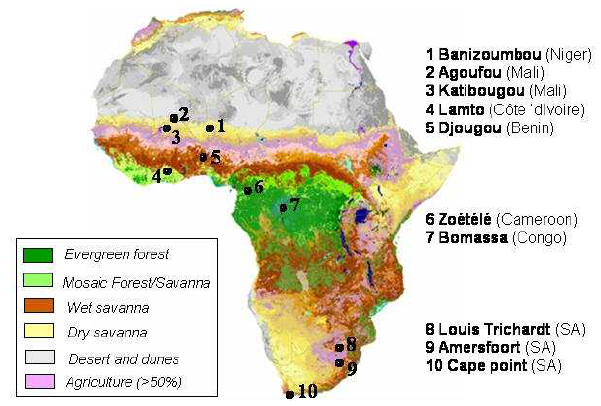
Fig. 1. Vegetation and location map of the 10 measurement stations Figure 1. Vegetation and location map of the 10 measurement stations of the IDAF network. of the IDAF